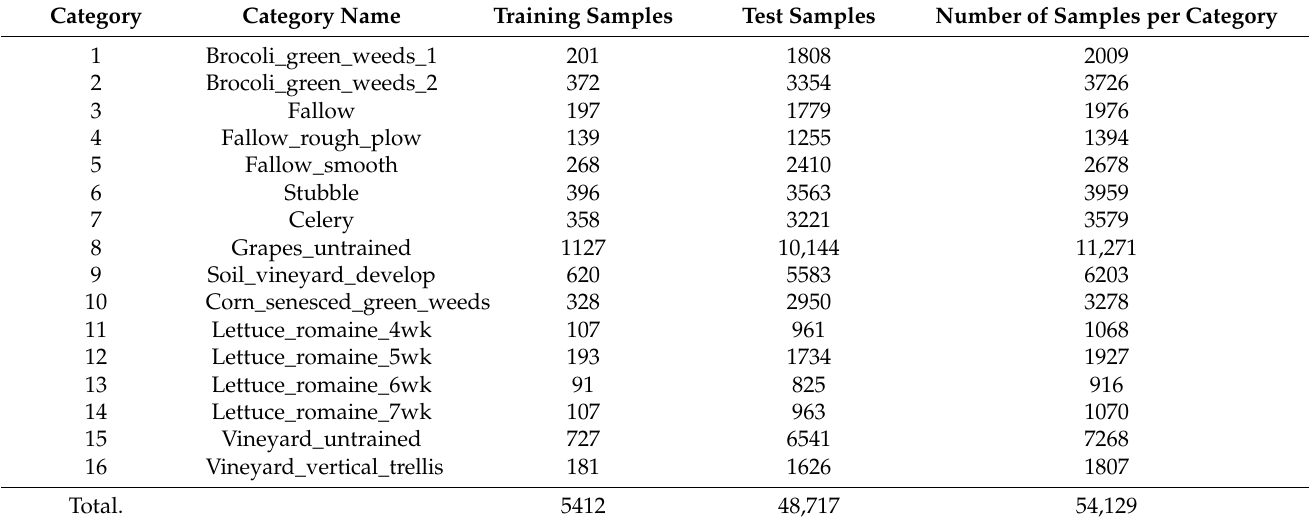
Table 4. Training and Testing Samples for